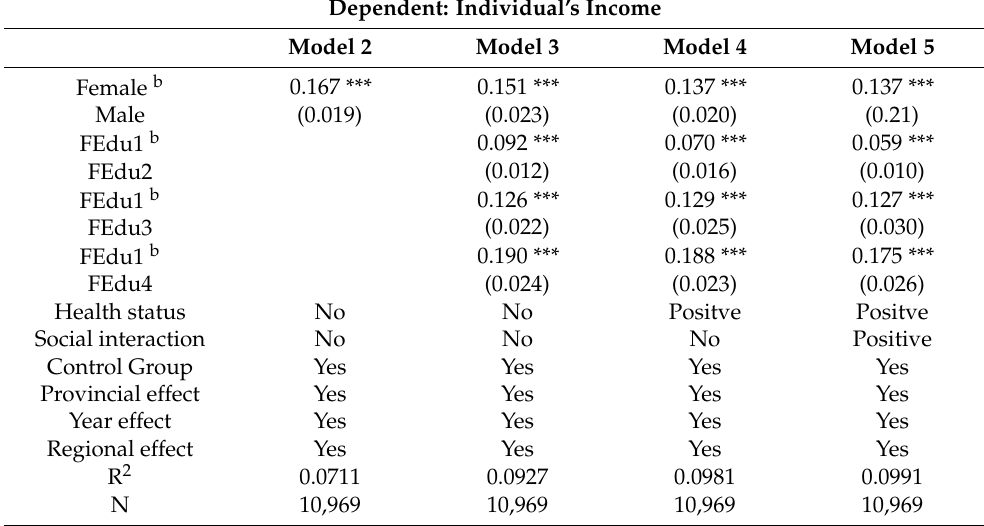
Table 7. Reduced form estimates on the relationship between father’s education and individual’s earnings, CGSS 2013 and